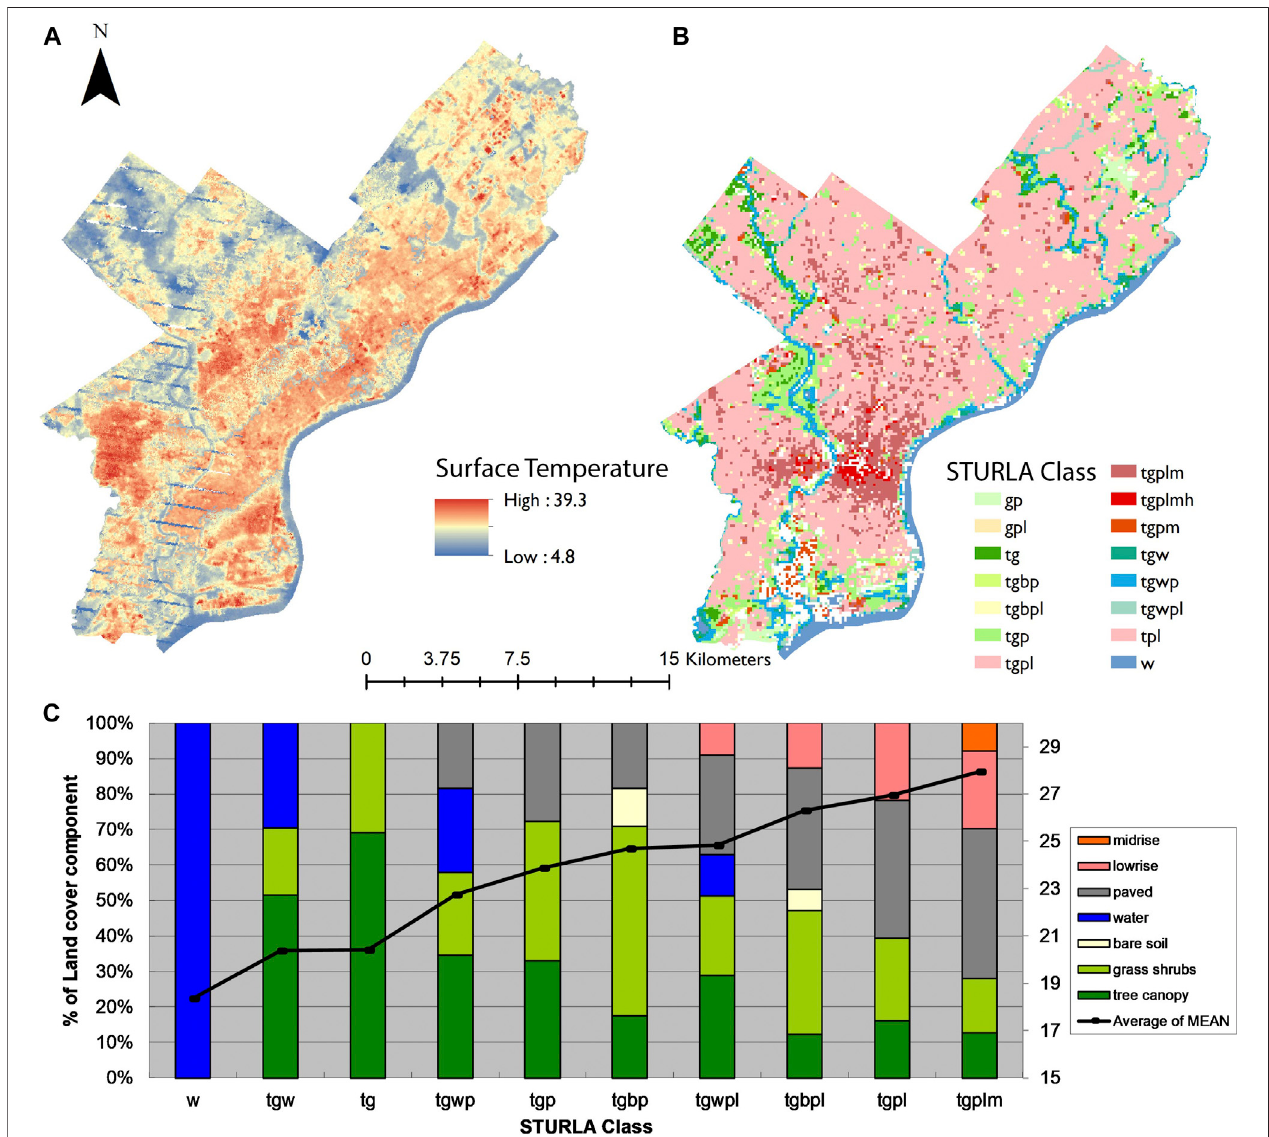
FIGURE 1 | (A) . Spatial distribution of STURLA classes (B) . Spatial distribution of ST in Philadelphia. (C) . STURLA classes, mean % landcover of individual components, and mean ST for Philadelphia. STURLA class codes: t-trees; g-grass; b-bare soil; w-water; p-paved; l-low building; m-medium